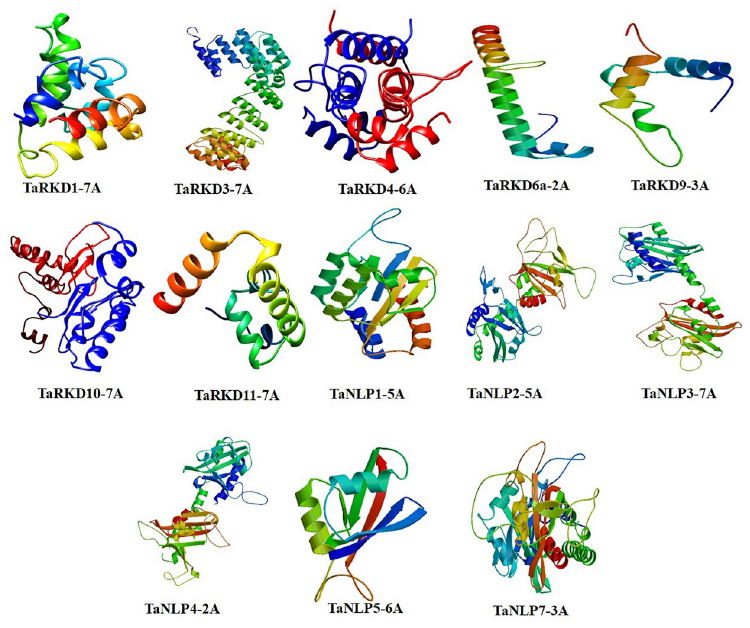
Fig 5. 3D structures of TaRKD and TaNLP proteins. In all figures, spirals are helices, broad strips with arrow-head are β -pleated sheets and thin loops are